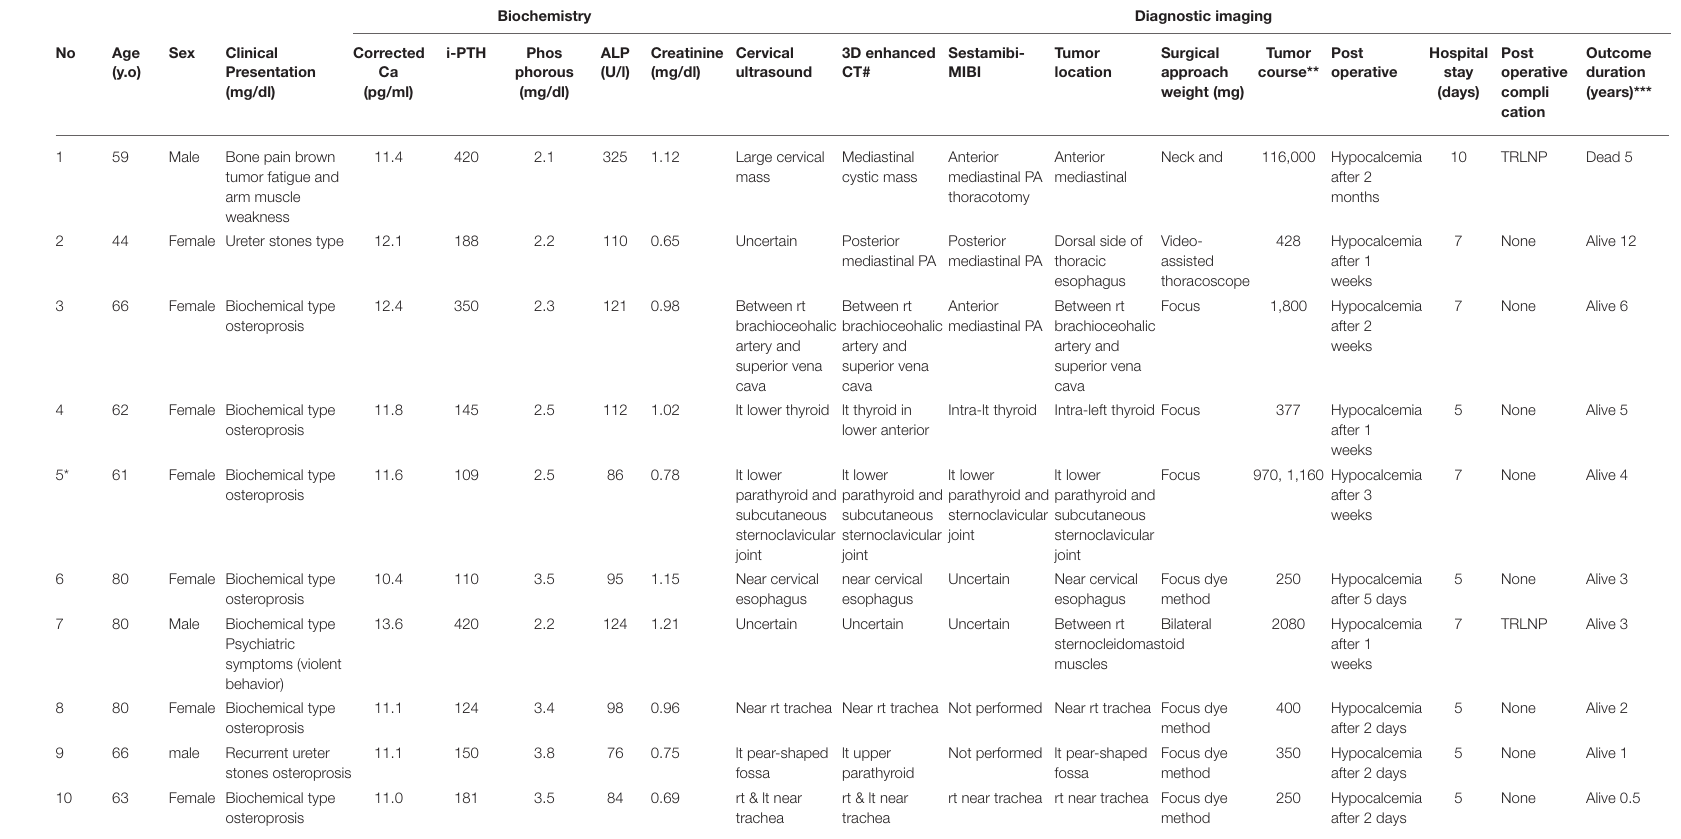
* Double adenoma case (i-PTH: intact-parathyroid hormone, PA, parathyroid adenoma; TRLNP, transient recurrent laryngeal nerve palsy), ** Normalised period, *** Duration of follow up, # CT (computed